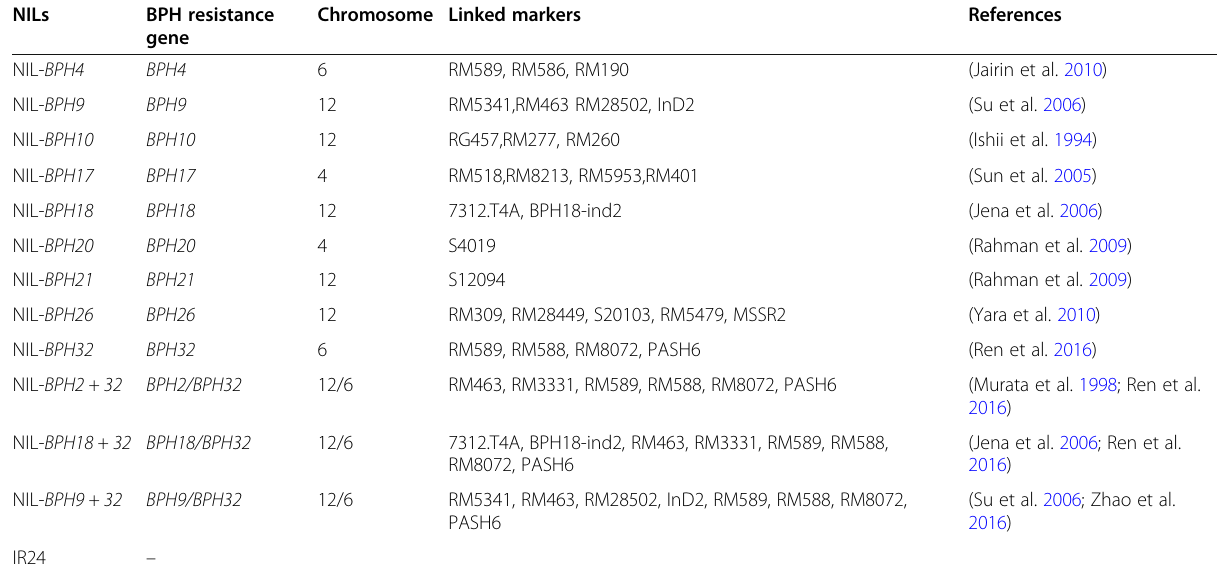
Table 1 The chromosome number and linked markers of BPH resistant genes in NILs NILs BPH resistance Chromosome Linked markers gene